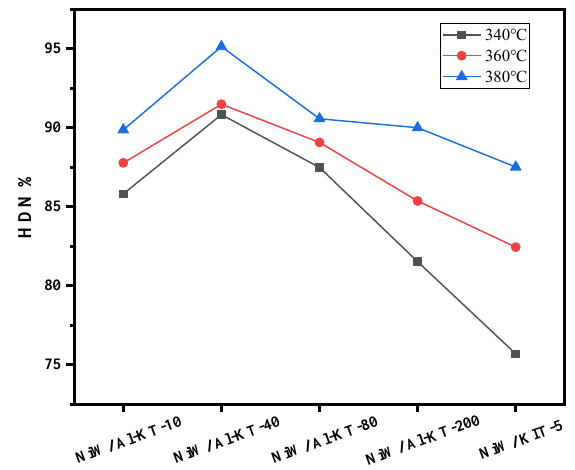
Figure 11. Hydrodenitrogenation (HDN) efficiencies of various catalysts at different temperatures.